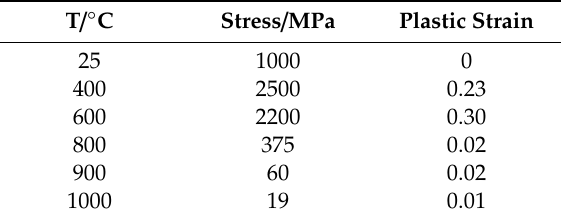
Table 2. Plastic parameters of the base coat (BC).